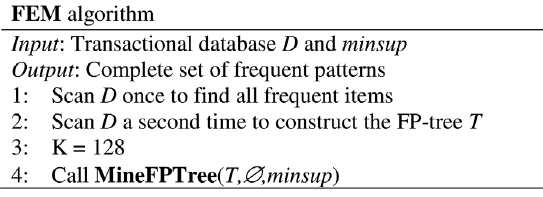
Figure 5. FEM Algorithm.